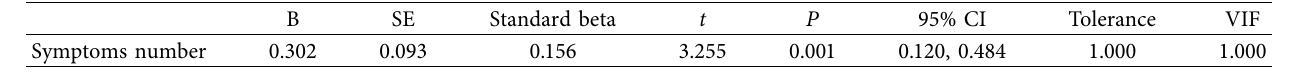
Table 6: Multiple linear regression of BTP episodes during